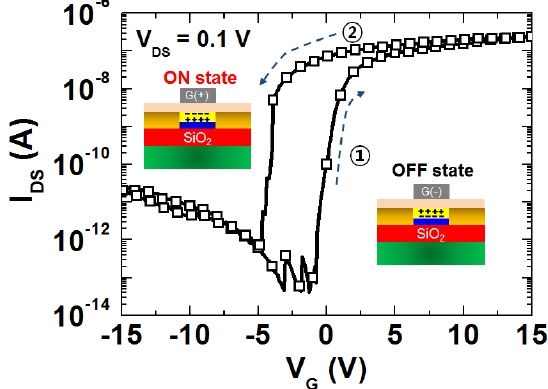
Figure 3. Hysteretic behaviour of a top-gate ZnO nanowire FET with a ferroelectric LC